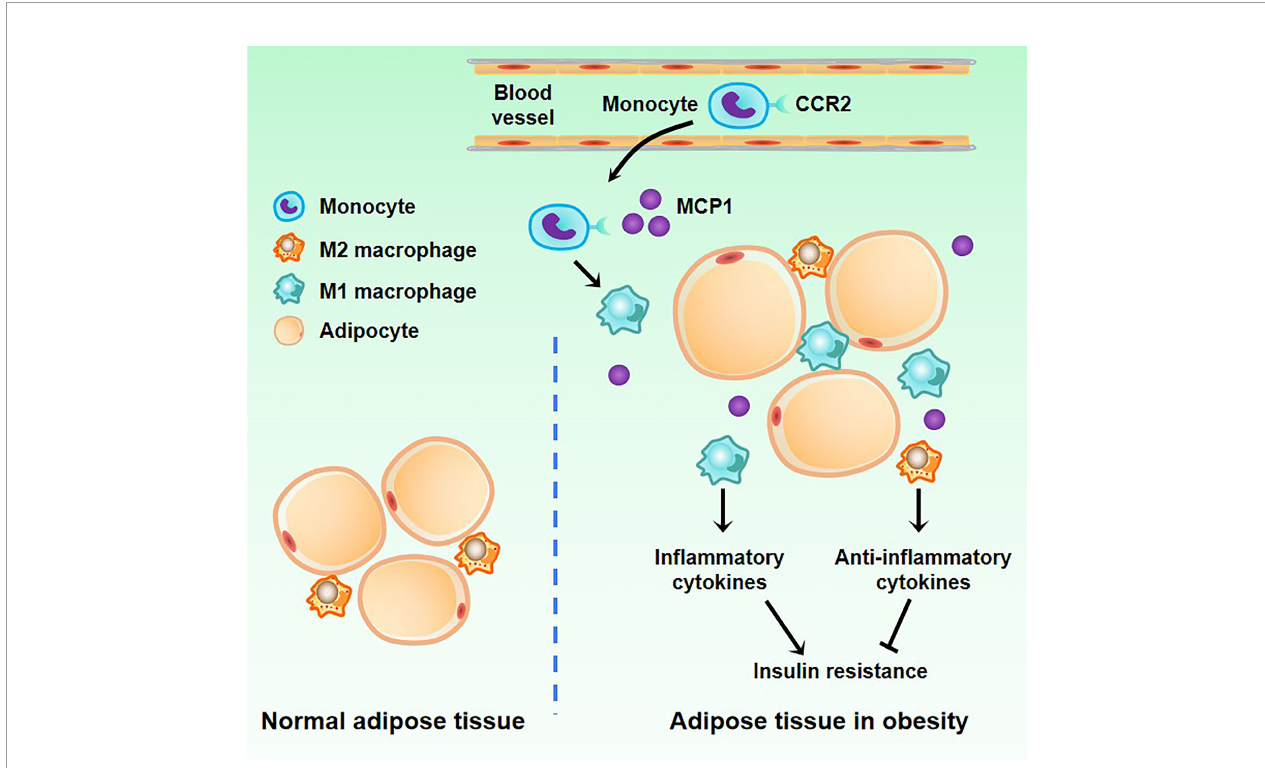
FIGURE 2 | Changes of macrophages in adipose tissue in obesity. There are a small number of M2 macrophages in normal adipose tissue. When obesity occurs, blood monocytes accumulate in adipose tissue. Under the induction of the MCP1 factor secreted by adipose tissue, monocytes differentiate into M1